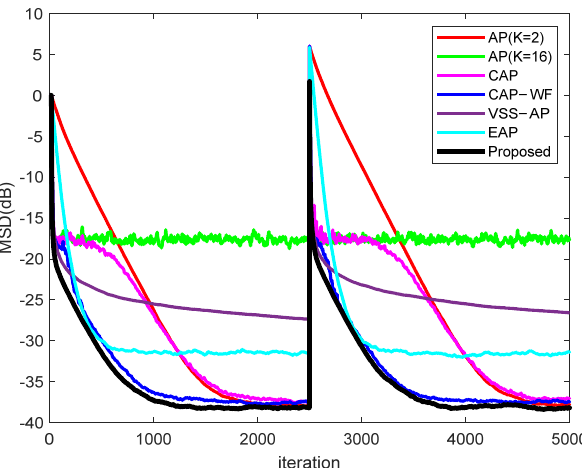
Figure 8. Convergence curves of the proposed algorithm and the conventional AP, CAP, CAP − WF, VSS − AP, and EAP algorithms in a non-stationary environment with SNR = 30 dB.